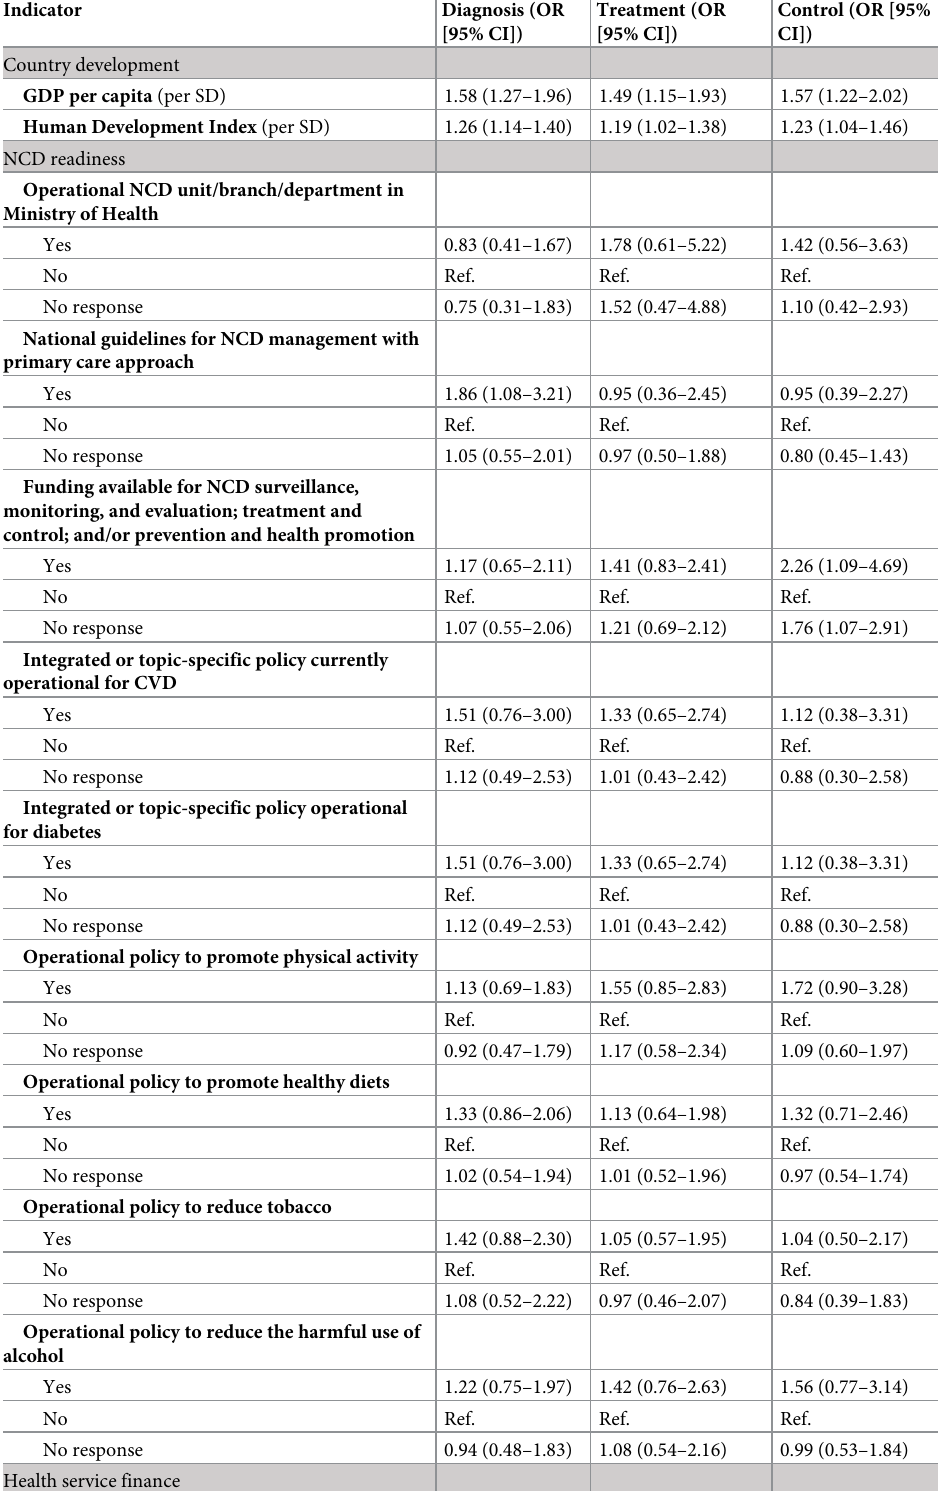
Table 5. Association between indicators and care for hypertension among individuals with